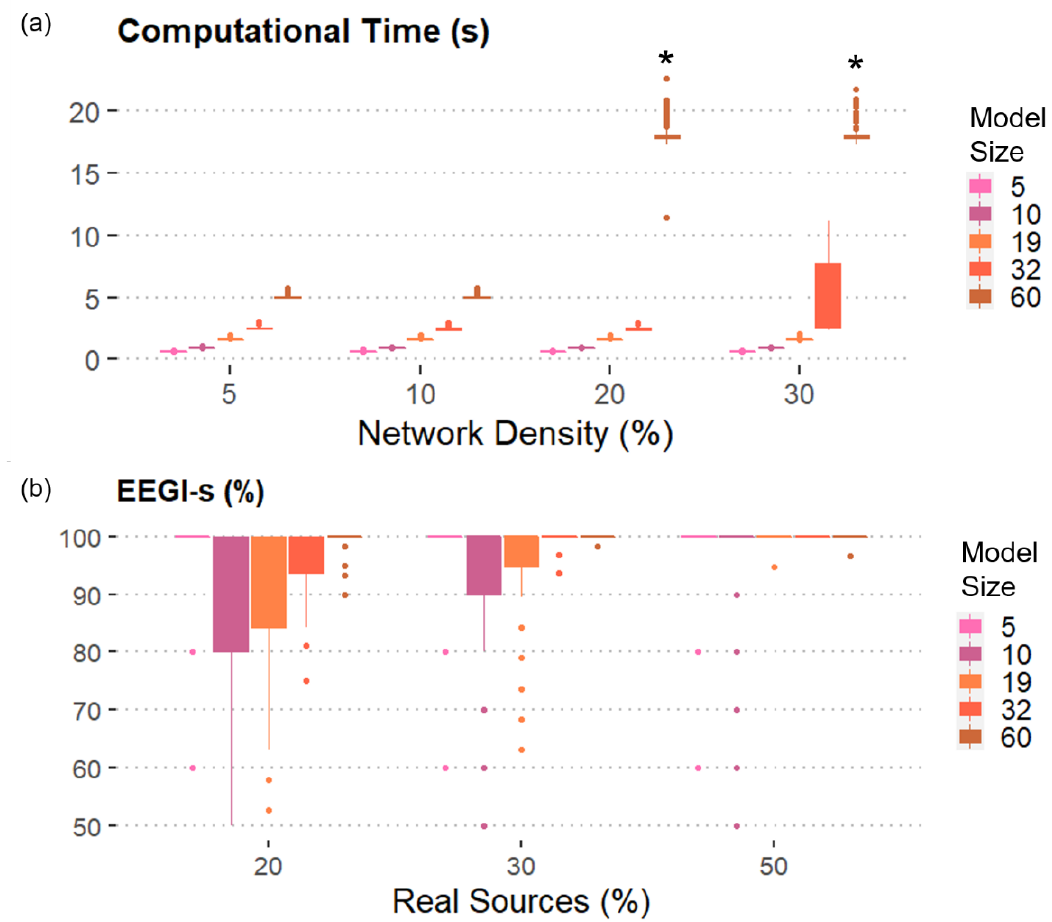
Figure 3. SEED-G performances in terms of computational time and percentage of realistic data generated: ( a ) Mean and standard deviation of the computational time computed over 300 iterations were shown as functions of the number of time series (Model size) and the number of existing connections (Network density). The number of real sources included is equal to 30%. Except for some 60-node models, all the simulated datasets composed by 100 trials were generated in less than 10 s. (*) encodes the fact that no dataset with that specific combination of features could be generated with 1000 attempts; ( b ) Mean and standard deviation of the percentage of EEG-like signals ( EEGl -s) computed over 300 iterations were reported as functions of Model size and of the number of real sources included in the connectivity model (Real sources). The density of the network is equal to 10%. On average, more than 80% of the generated data reported EEG-like spectral properties.